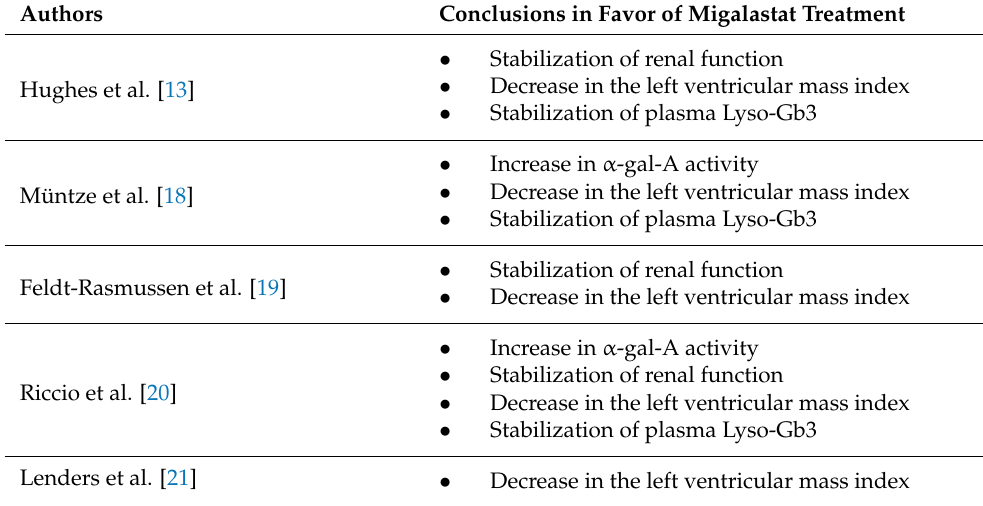
Table 2. Conclusions of the